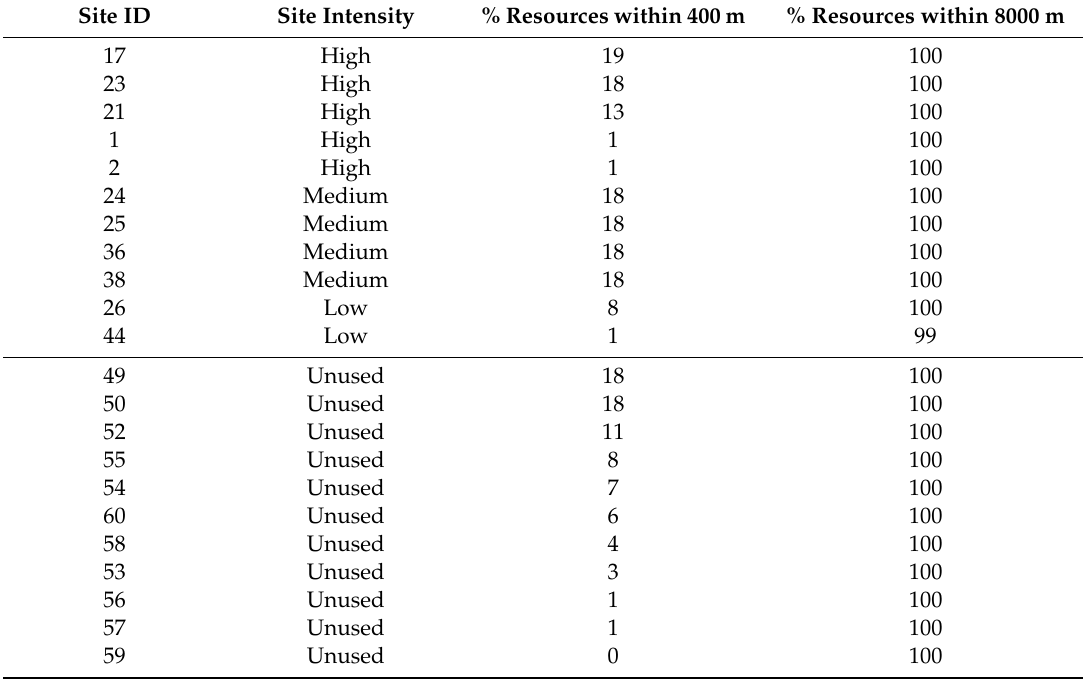
Figure 4. Map showing categories of resources juxtaposed against overlapping 400-meter walking distance bu ff ers around used and unused abandoned houses. Table 2. The percentage of resources within 400-meter and 8000-meter walking distance areas of used and unused abandoned